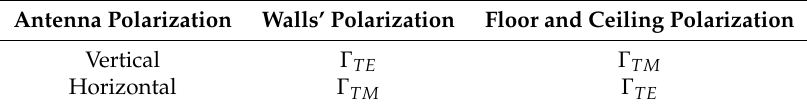
Table 1. Reflection coefficients for fundamental